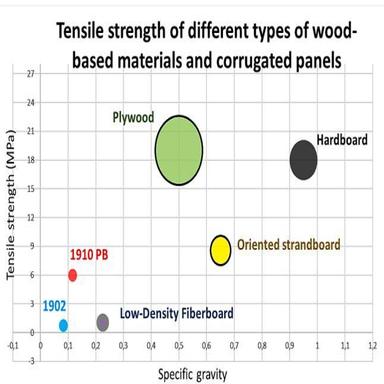
Tensile strength of different types of wood-based materials and corrugated panels.